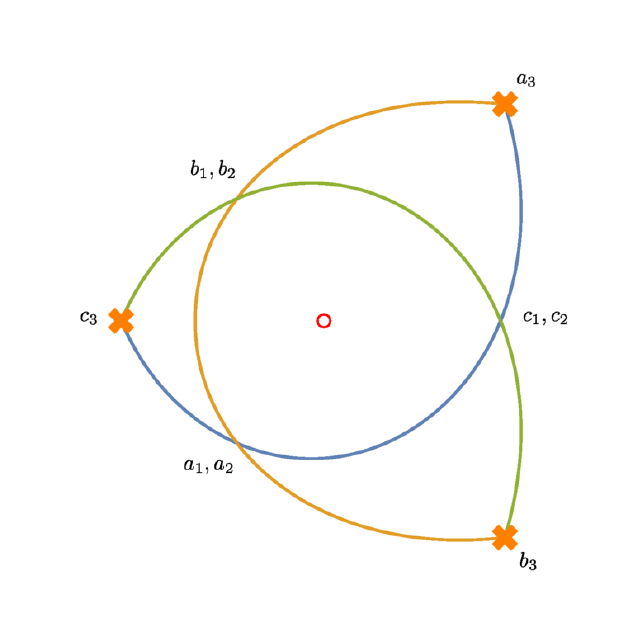
Figure 28. The three fractional branes near the orbifold point and the bifundamental (cid:12)elds corre- sponding to their intersection points. Note that the fractional branes all occur at di(cid:11)erent phases. Figure 29. Central charges of the fractional branes at = (cid:0) 1